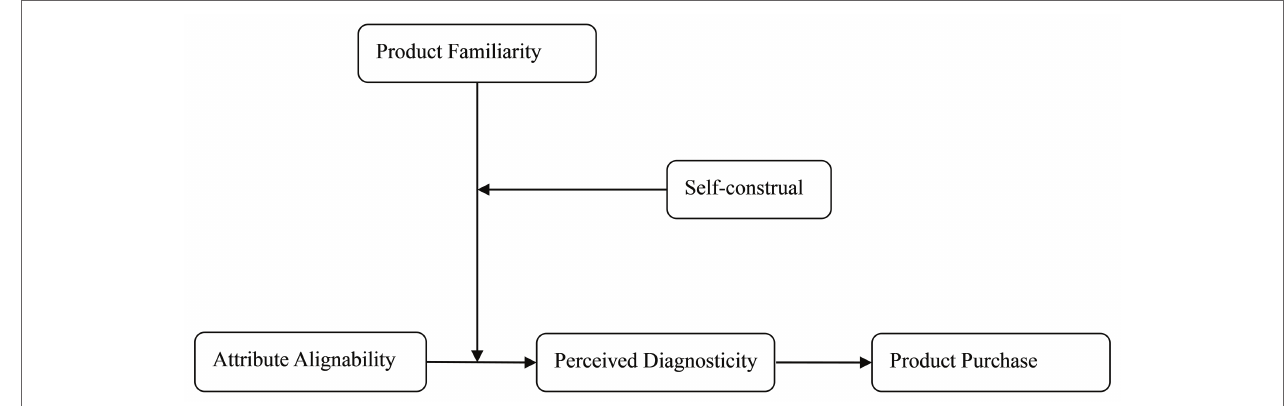
FIGURE 1 | The research